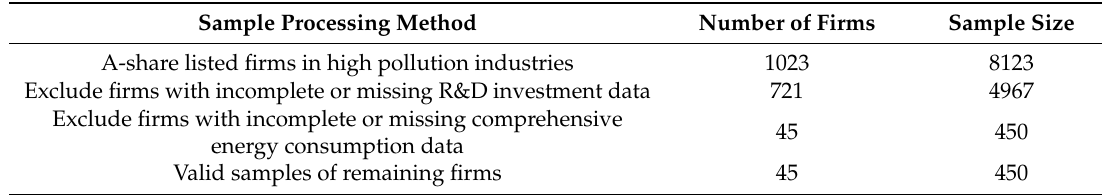
Table 1. Screening process of sample